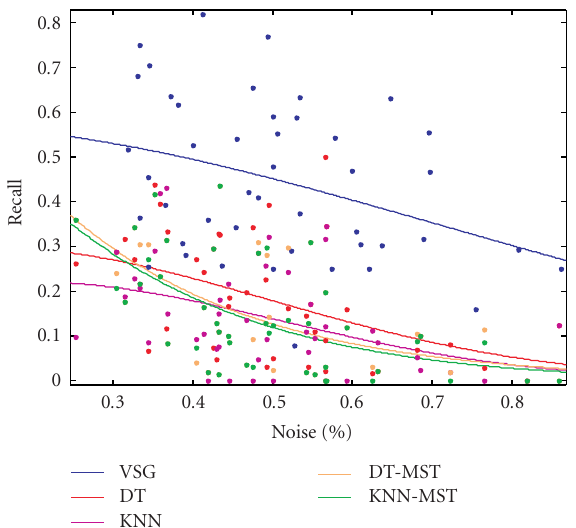
Figure 9: The performance of several topological structures in graph matching under various outlier percentages.